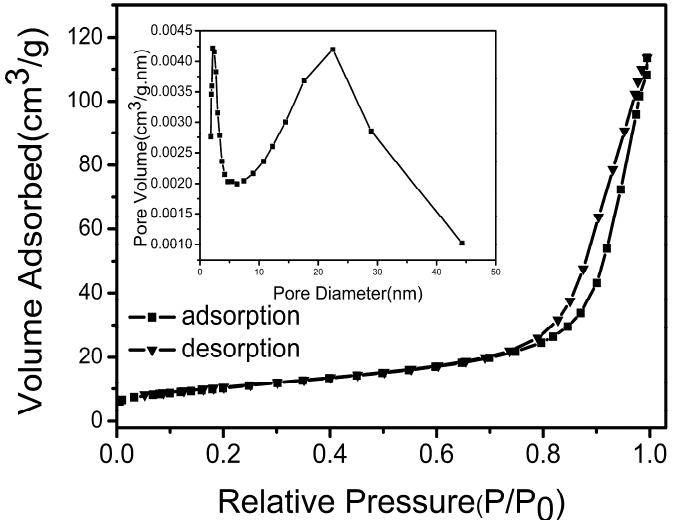
Figure 5. N 2 adsorption and desorption isotherms and pore size distribution (PSD) curve (insert) for hierarchical Bi 2 WO 6 hollow microspheres.